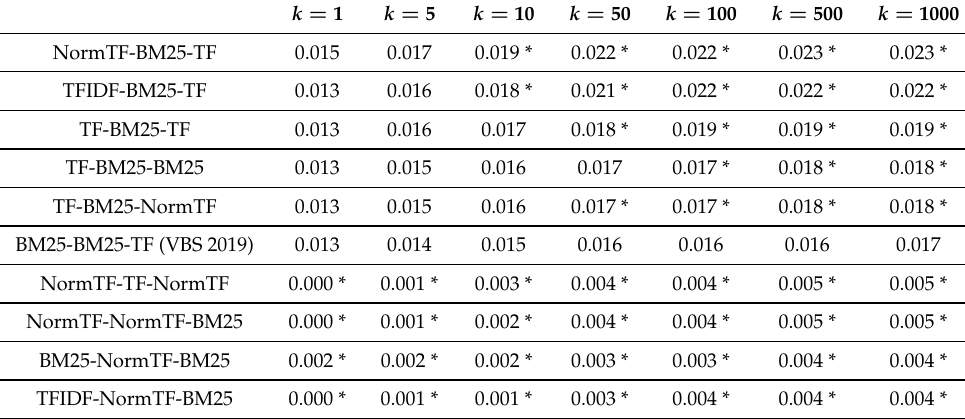
Figure 11. MRR of the 64 combinations of ranker: the one filled with diagonal lines is the combination used at the VBS2019 competition. Each configuration is denoted with a triplet R BB - R AN - R OC where R BB is the ranker used for the BBox Search, R AN is the ranker used for the Annotation Search, and R OC is the ranker used for the OClass Search. Statistically significant results with two-sided p value lower than 0.05 over the baseline BM25-BM25-TF are marked with * in the graph. Table 1. MRR@k for eight combinations of the rankers (the four best, the four worst and thesetting used at VBS2019) varying k.Statistically significant results with two-sided p value lower than 0.05 over the baseline BM25-BM25-TF are marked with